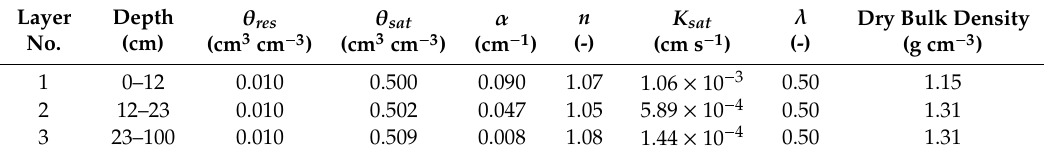
Table 4. Initial Mualem–van Genuchten parameters and dry bulk density.